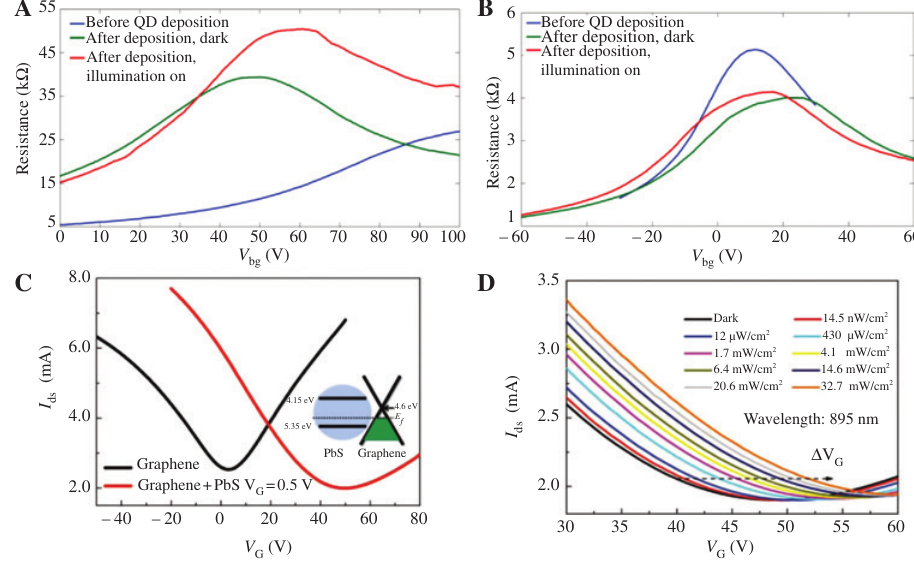
Figure 7: Shift of the gate voltage due to QD deposition and the light-induced shift of the gate voltage in the device with undoped graphene (A) and p-doped graphene (B) and PbS QDs [7]. (C) Gate voltage shift due to PbS QD deposition in graphene phototransistor and (D) the light-induced shift of the gate voltage